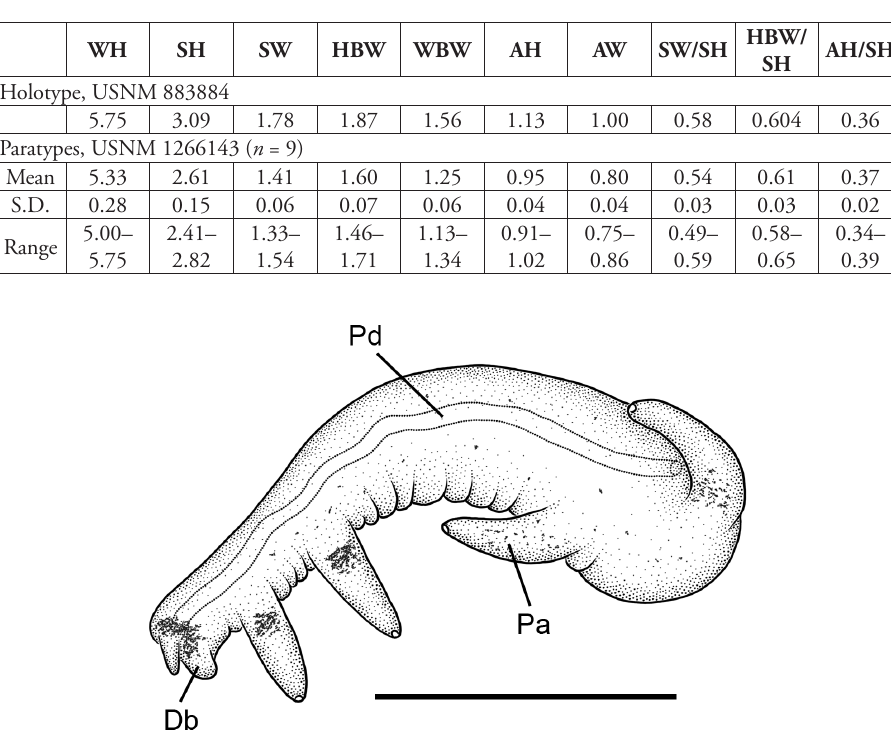
Figure 5. Penis (dorsal surface), T. infernalis , USNM 1248362. Scale bar: 500 µm. Db distal bulb Pa distal papilla Pd penial